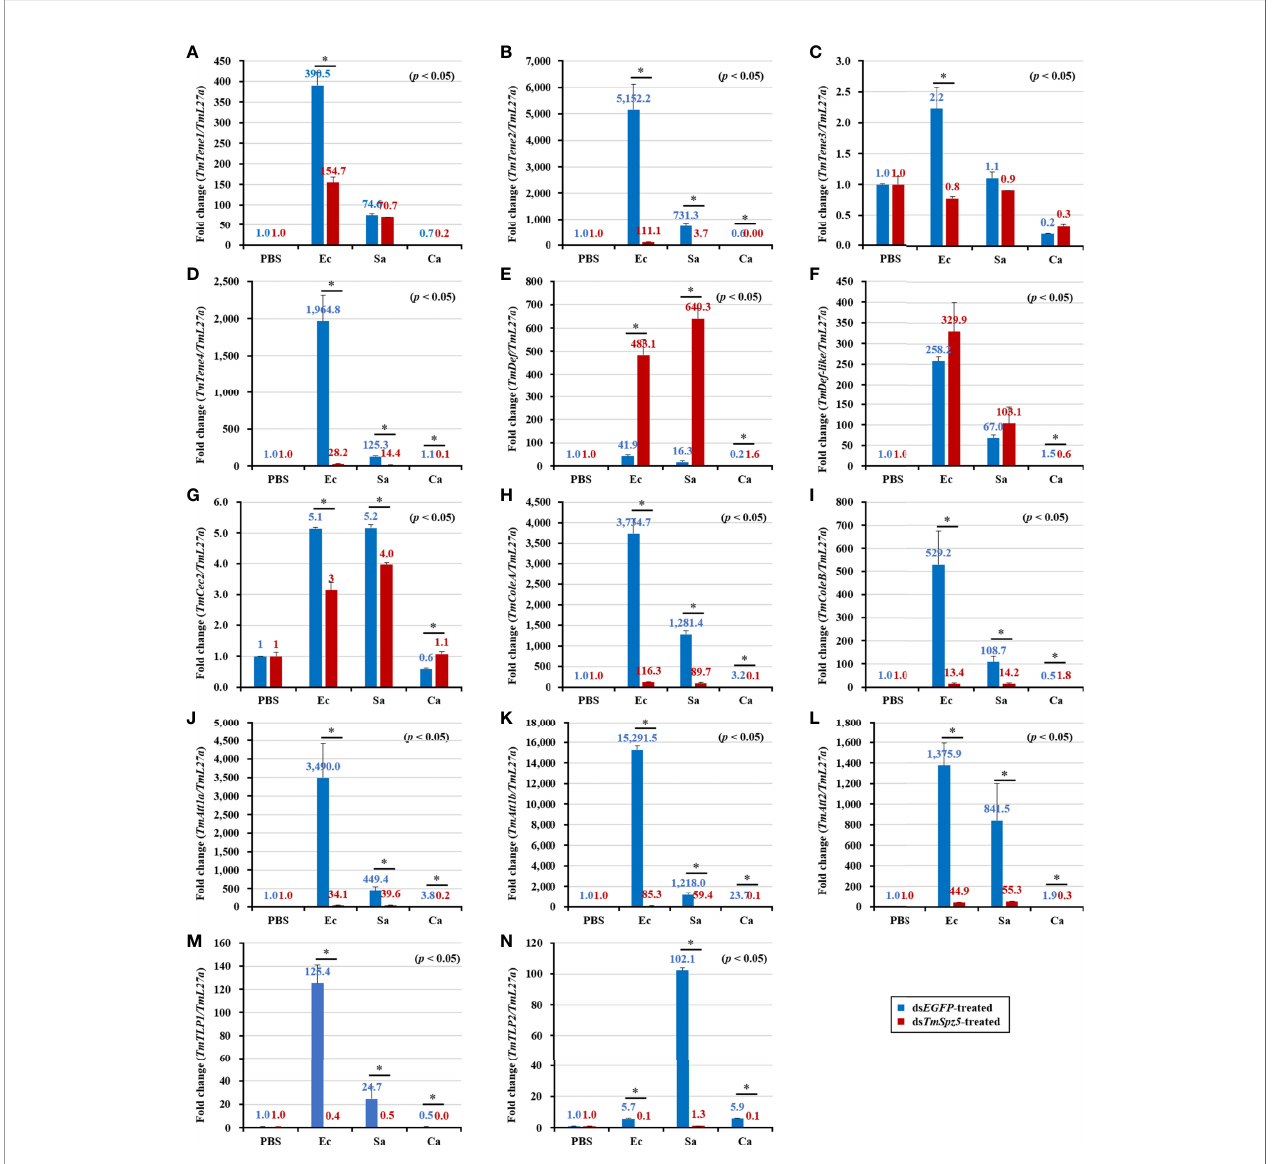
FIGURE 6 | Induction of 14 AMP genes in the Malpighian tubules of TmSpz5 -silenced T. molitor larvae infected with E. coli (Ec) , S. aureus (Sa), and C. albicans (Ca) using PBS as control. At 24 h after microbial injection, AMP genes, including TmTene1 (A) , TmTene2 (B) , TmTene3 (C) , TmTene4 (D) , TmDef (E) , TmDef-like (F) , TmCec2 (G) , TmColeA (H) , TmColeB (I) , TmAtt1a (J) , TmAtt1b (K) , TmAtt2 (L) , TmTLP1 (M) , and TmTLP2 (N) were examined by qPCR using ds EGFP as a knockdown control and T. molitor ribosomal protein ( TmL27a ) as an internal control. All experiments were performed in triplicate. Asterisks indicate signi fi cant differences between ds TmSpz5 - and ds EGFP -treated groups determined by Student ’ s t -test ( p <